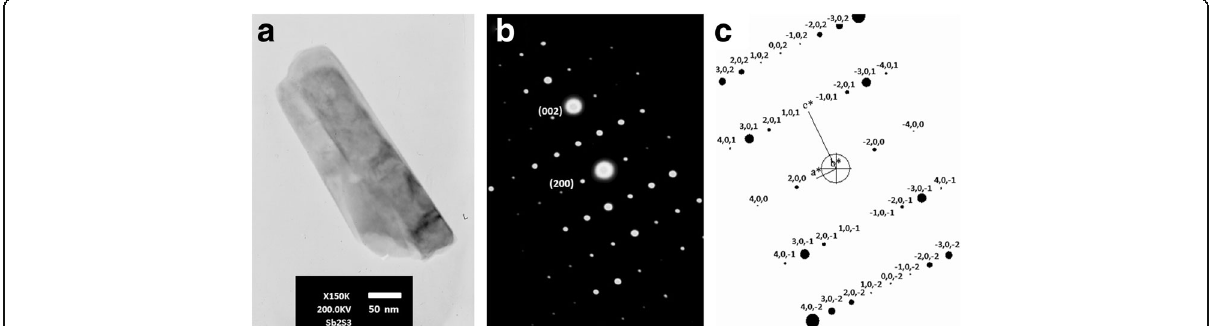
Fig. 3 a TEM image, b SAED pattern, and c simulated pattern of the 0.3 HEC-Sb 2 S 3 product